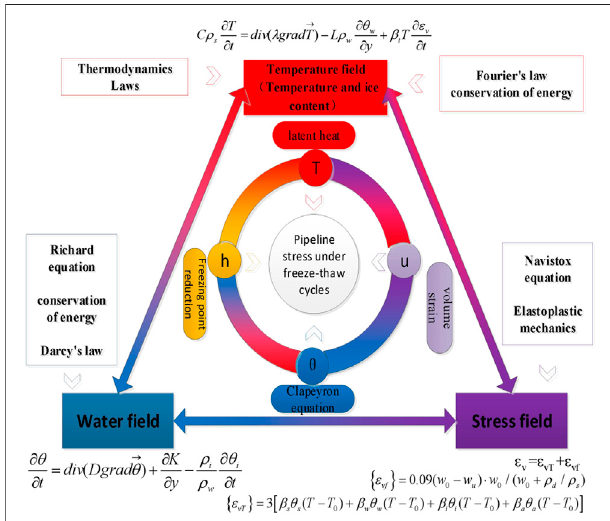
FIGURE 13 | THM coupling mechanism and